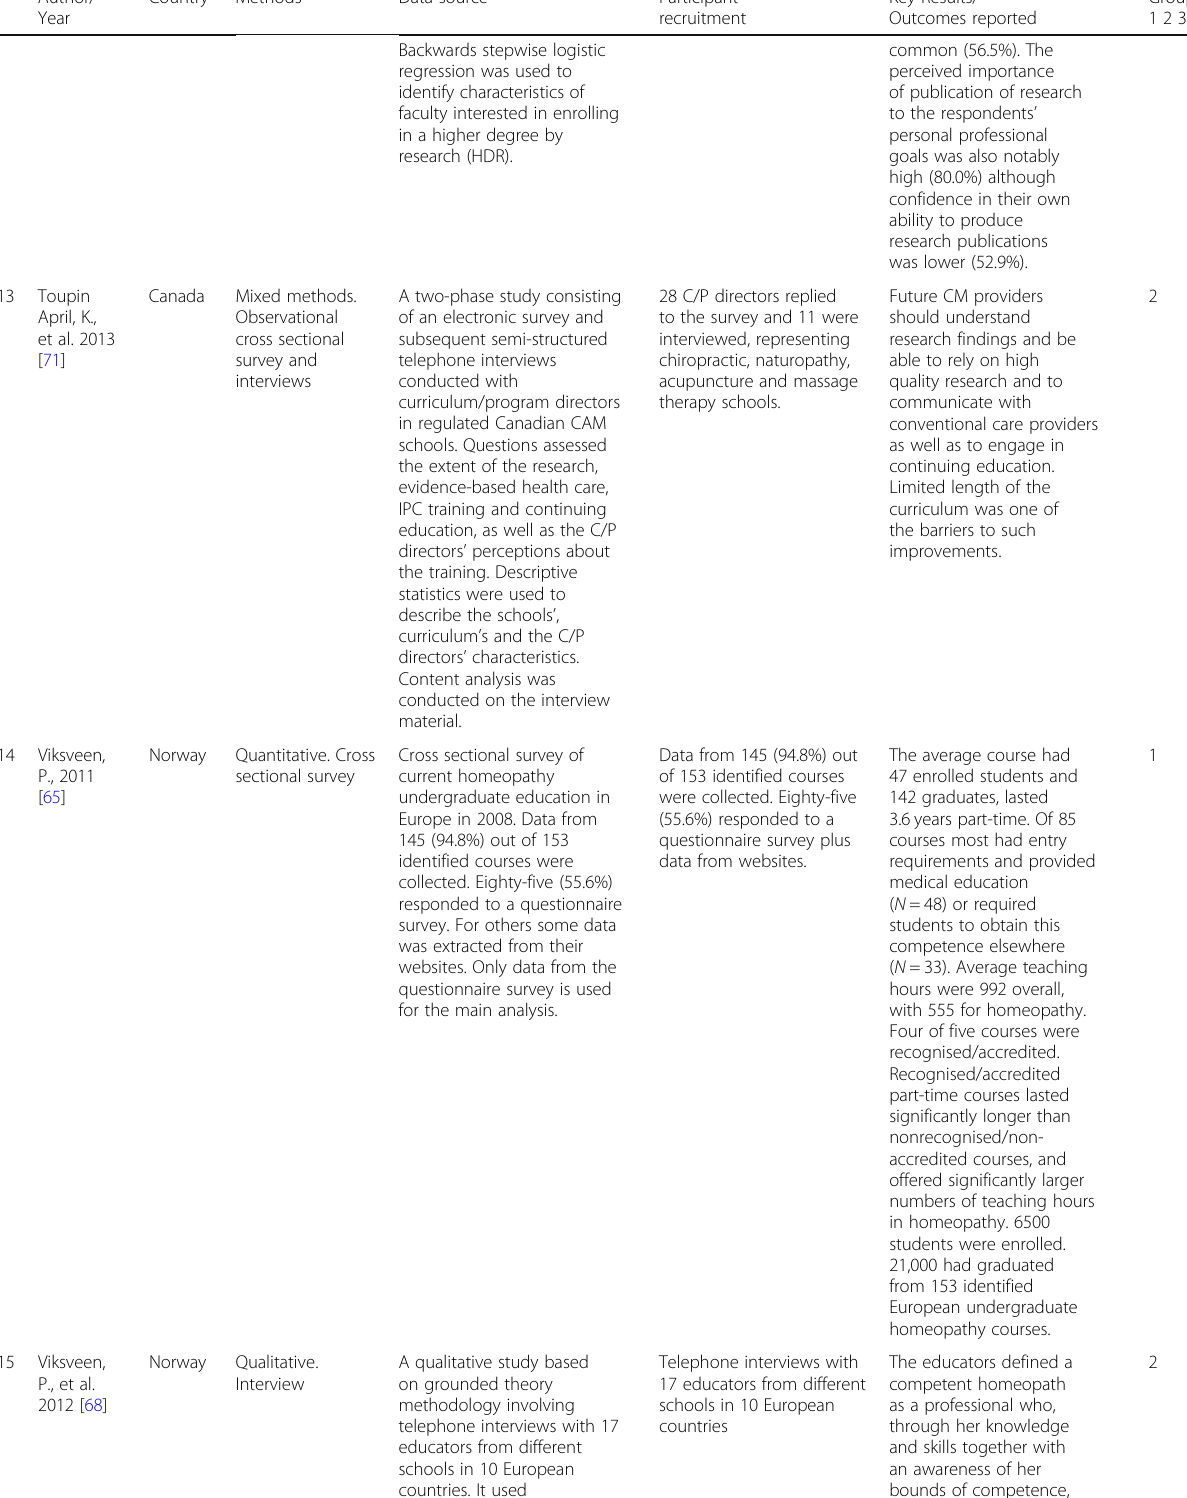
Table 2 Study Characteristics of Included Studies and Thematic Categories (1 CM education provision, 2 The development of educational competencies to develop clinical skills and standards, 3 Application of new educational theory, methods and technology in CM, 3 Future Challenges facing CM education)